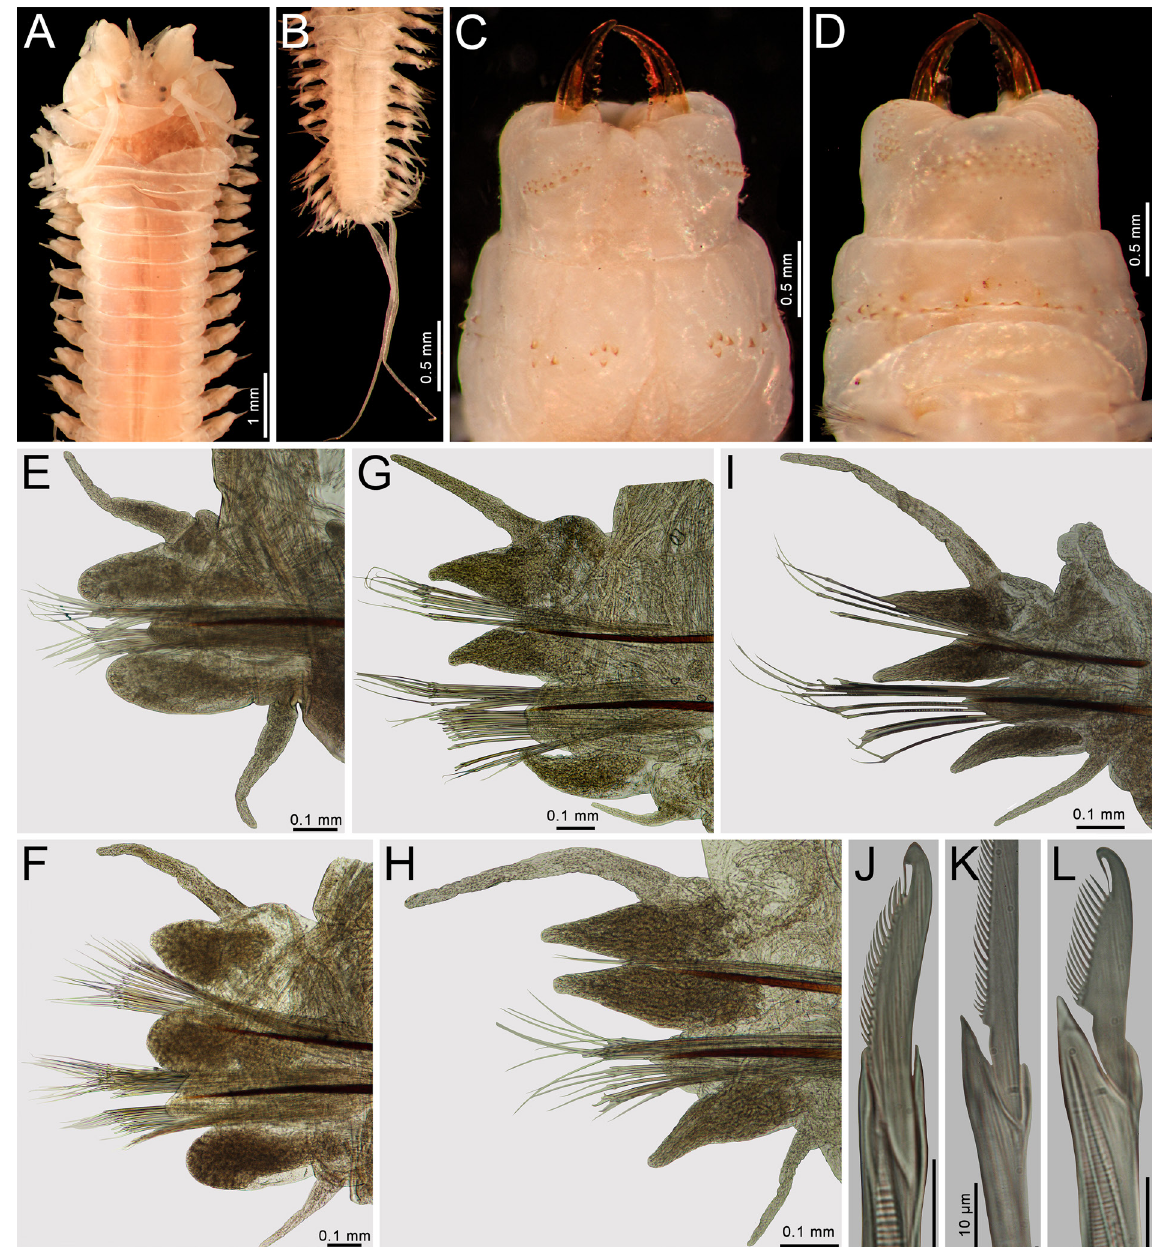
Fig. 17. Nereis occidentalis Hartman, 1945. A–B, I: holotype (LACM 836); C–H, J–L: paratype (LACM 837). A . Anterior region, dorsal view. B . Posterior region, dorsal view. C . Pharynx, dorsal view. D . Same, ventral view. E . Chaetiger 2, right parapodium, posterior view. F . Chaetiger 11, right parapodium, posterior view. G . Chaetiger 34, right parapodium, posterior view. H . Chaetiger 62, right parapodium, posterior view. I . Chaetiger 87, right parapodium, posterior view. J . Same, notopodial homogomph falciger. K . Same, neuropodial subacicular heterogomph spiniger. L . Same, neuropodial subacicular heterogomph